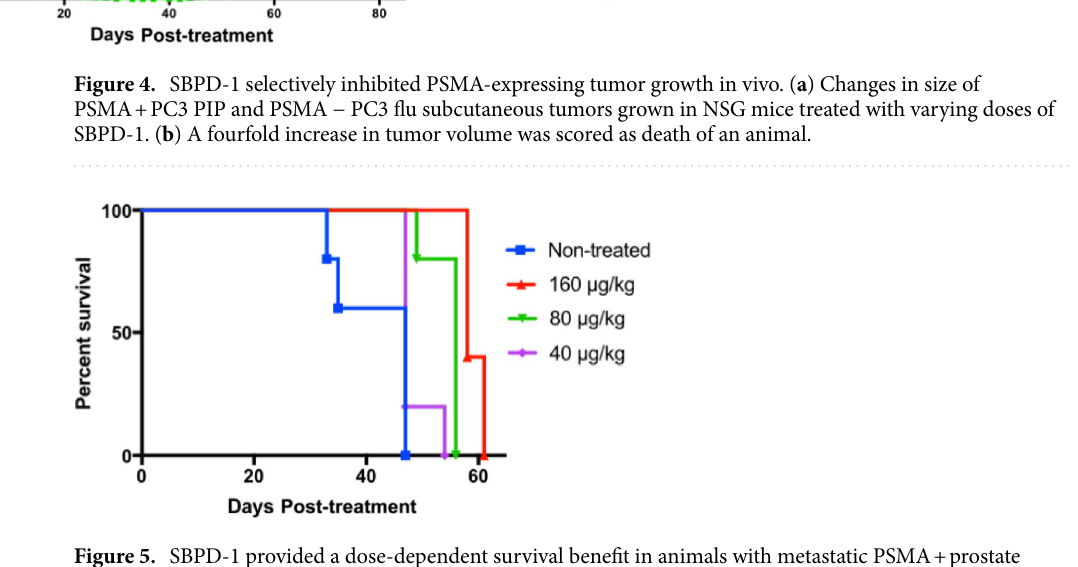
Figure 5. SBPD-1 provided a dose-dependent survival benefit in animals with metastatic PSMA + prostate cancer. Survival curves representing mice treated with the indicated doses of SBPD-1. Animals harbored metastatic tumors derived from PSMA + PC3/ML/PSMA cells administered